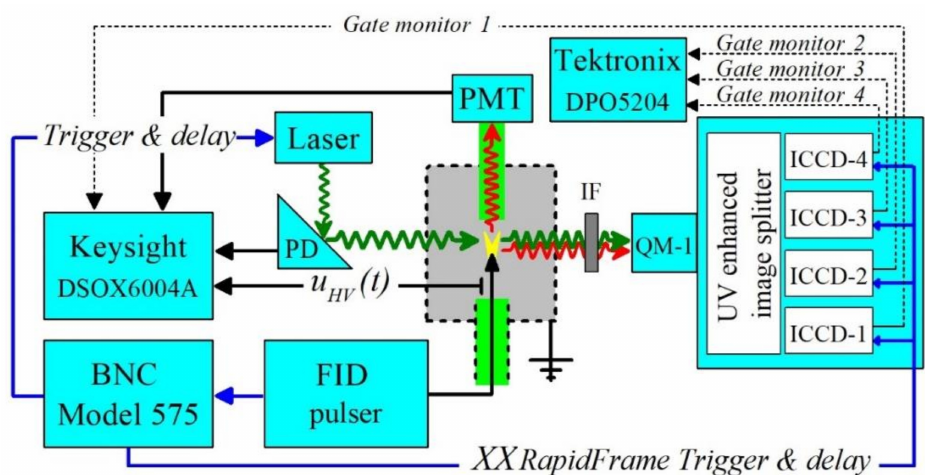
Figure 2. Block scheme of the experimental setup for electrical and optical emission, and XXRapidFrame-based micro- scopic